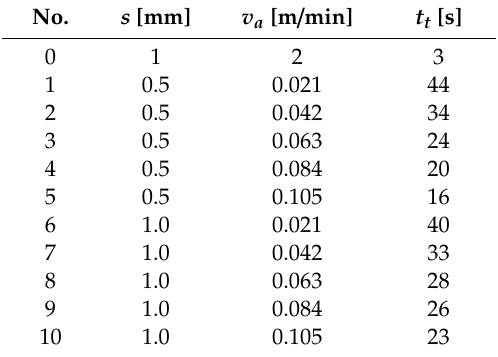
Table 7. The dependence of the cutting time, the feed rate of the PO, and the thickness of the metal band. No. Table 8. The dependence of the width of the cut, on the relative speed of the TO and on the thickness of the metal band.